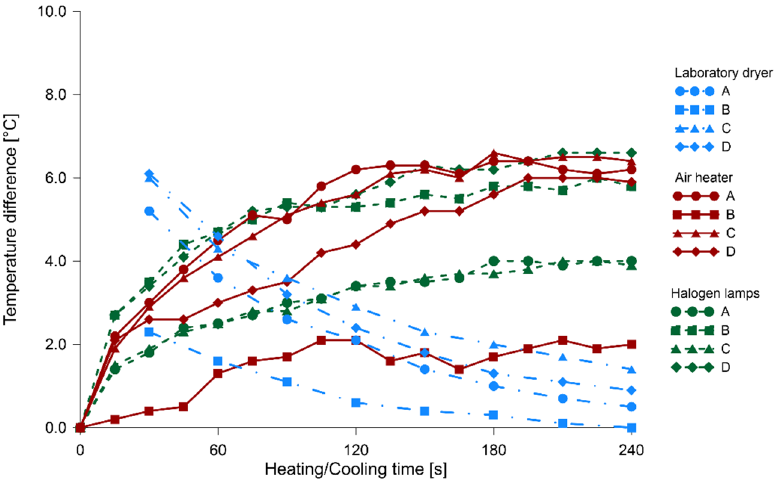
Figure 7. The relationship between heating/cooling time and temperature difference of solid fir wood and knots.